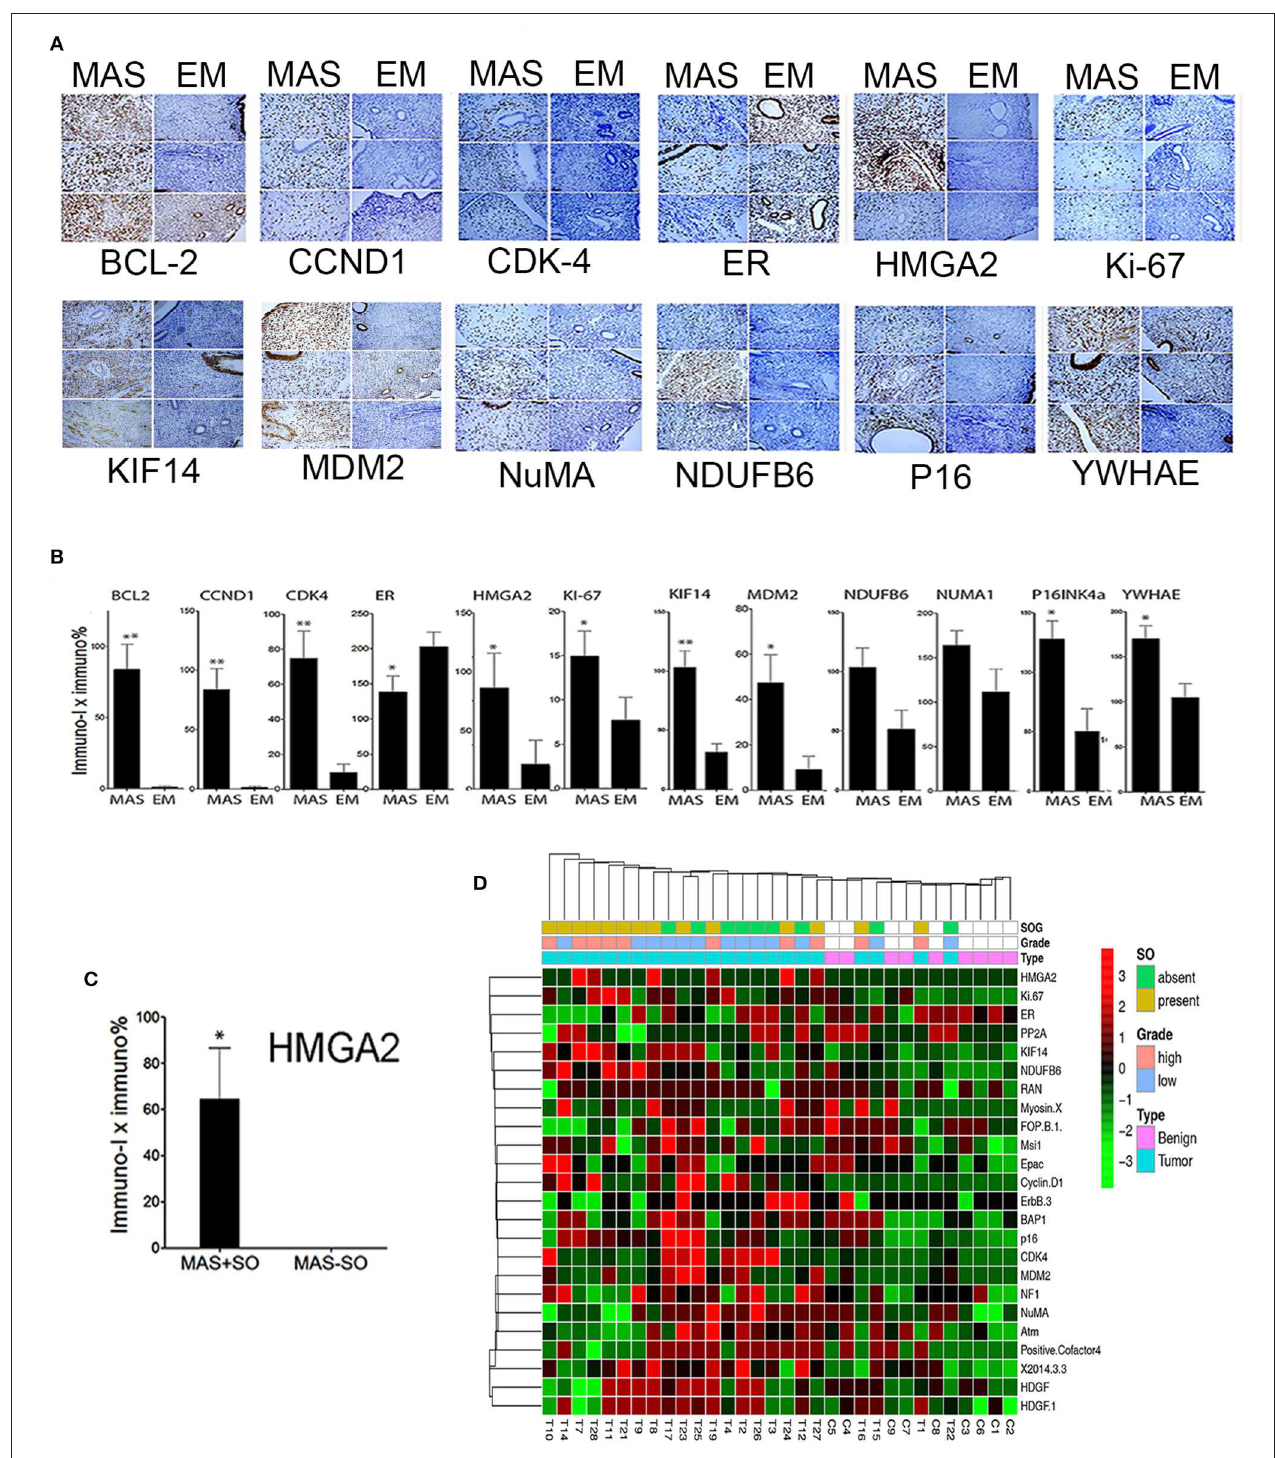
FIGURE 2 | Expression analysis of selected gene products by immunohistochemistry. (A) Photomicrographs illustrating the immunohistochemical staining pattern of endometrium (EM) and Müllerian adenosarcoma (MAS) in three selected cases of each. Immunostaining was performed to detect the biomarkers are listed below each panel. (B) The relative immunoreactivity (intensity × percentage) of the selected biomarkers is presented in histobars for MAS ( N = 29) and EM ( N = 8). Small t bars represent standard error. (C) Significant HMGA2 protein expression in MAS with sarcomatous overgrowth (MAS + SO) vs. without (MAS-SO). (D) Unsupervised Dendragram Treeviews of protein expression of 24 biomarkers in normal endometrium (benign, blue) and MAS (pink) at different tumor grades and with or without SO (indicated in index bars above) and organ site. All immunoscores from D were normalized to generate the scores from negative to positive for a better visualization of expression pattern. * p < 0.05, ** p < 0.01.